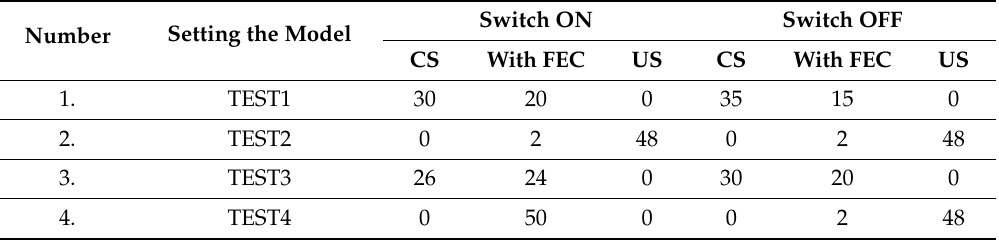
Table 3. Results of the statistical tests, correct switching (CS), unsuccessful switching (US) and correct switching with Forward Error Correction